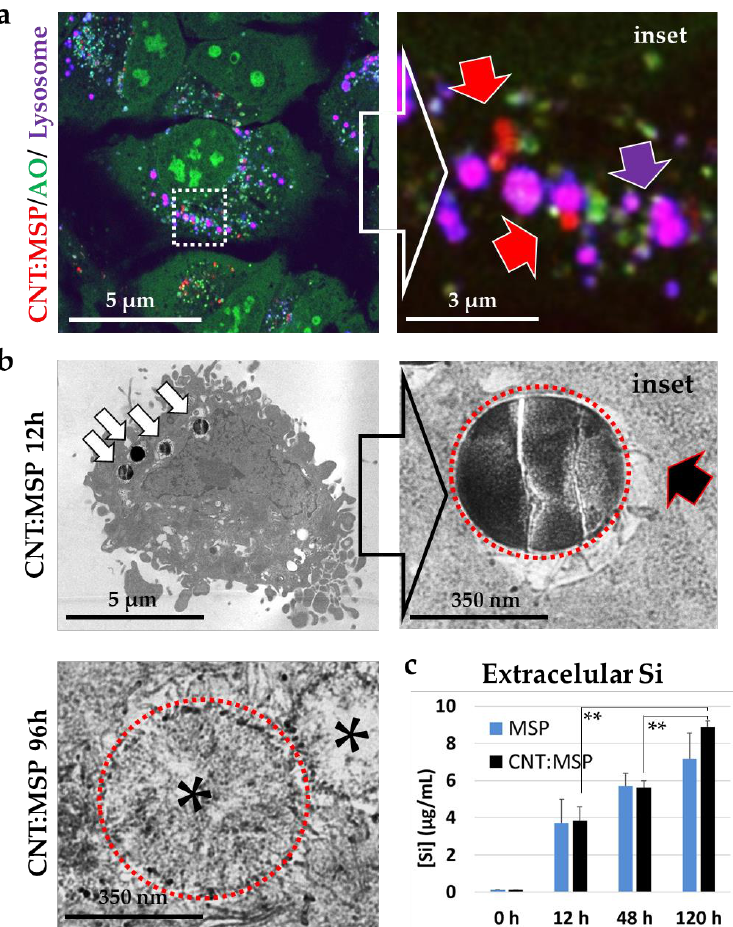
Figure 4. Subcellular localization and degradation of MSP with CNT coating (CNT:MSP) in HeLa cells. ( a ) Confocal microscopy images of live cells exposed to RBTIC-labelled CNT:MSP (red channel), Cells were stained with AO (green channel) and the lysosomal probe Lysotracker ® (blue channel). (inset) Purple arrows point to lysosomes containing particles, red arrows point to particles released into the cytosol. ( b ) TEM images of ultrathin sections of HeLa cells exposed to CNT:MSP. White arrows point to endocytosed particles. The inset shows CNTs piercing the lysosomal membranes (black arrow). Cytoplasmic CNT:MSP were significantly degraded 96 h after endocytosis, displaying empty cores (asterisks). For identification purposes, particles are surrounded by a red circle. ( c ) Quantitative ICP-OES analysis of Si in the extracellular culture media of the cells exposed to MSP or CNT:MSP during 0, 12, 48, and 120 h. The histogram represents the results average measurements of three experiments. The increment of the Si species in the culture media suggests the extracellular presence of the SiO 2 degradation products. Results confirm extracellular MSP and intracellular CNT:MSP dissolution ( ** = p <